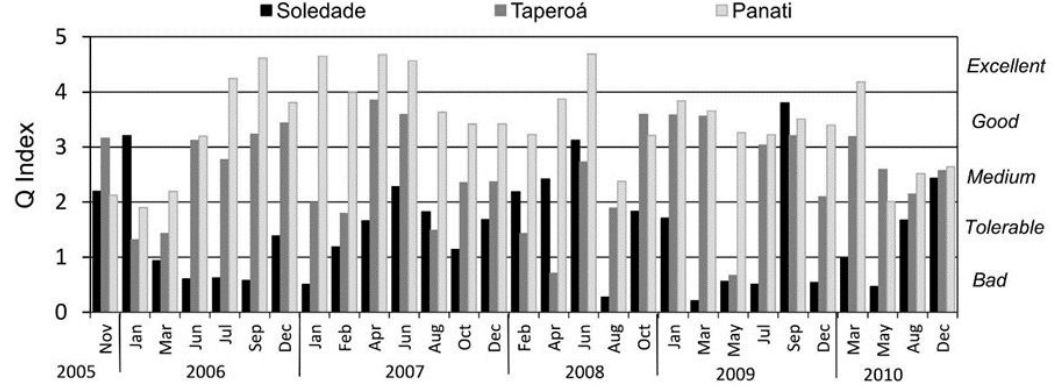
Figure 7. Ecological status of the Soledade and Taperoá reservoirs and Panati lagoon through the Q index of phytoplankton functional groups (November 2005 to December